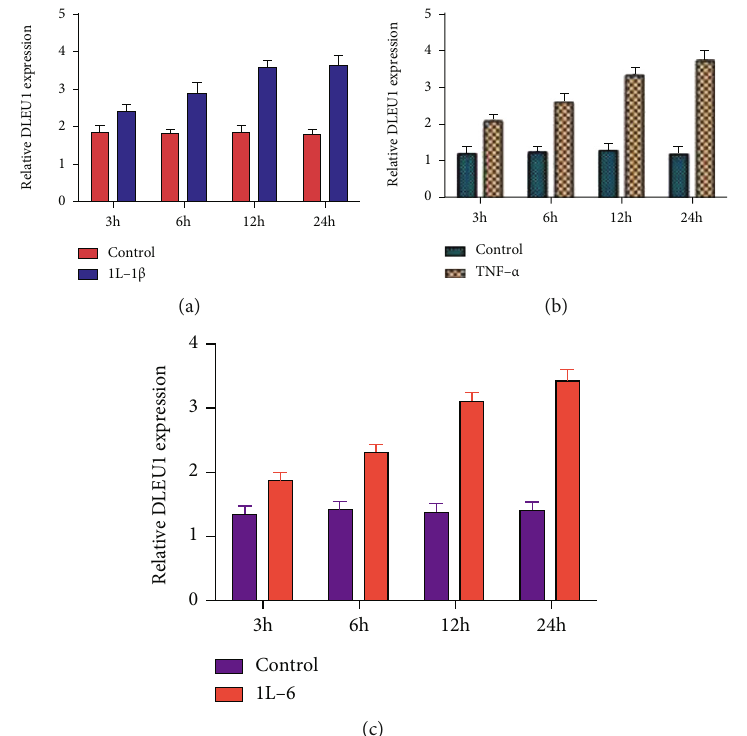
Figure 4: In fl ammatory cytokines IL-1 β , TNF- α , and IL-6 induced DLEU1 expression. (a) In fl ammatory cytokine IL-1 β increased DLEU1 expression in chondrocytes. (b) The expression of DLEU1 was measured by qRT-PCR analysis. (c) IL-6 induced DLEU1 expression in